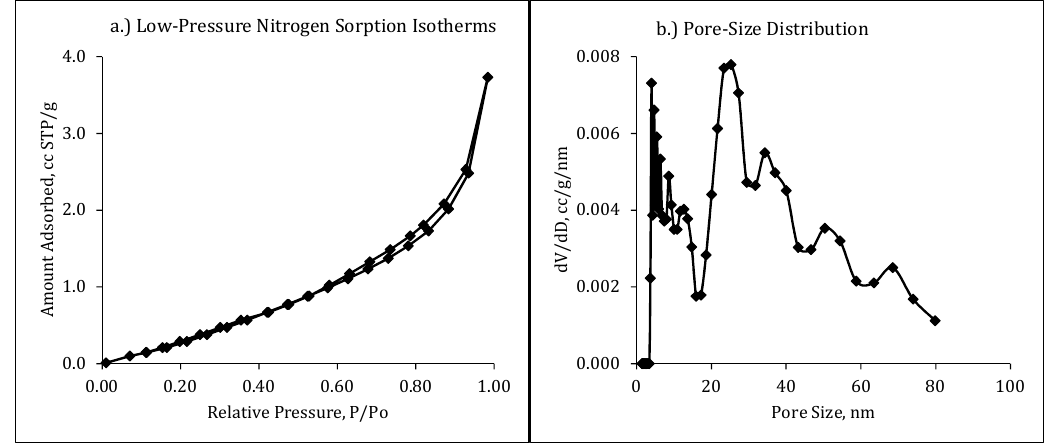
Figure 1. Pore-Size Distribution from Low-Pressure Nitrogen Adsorption Data.